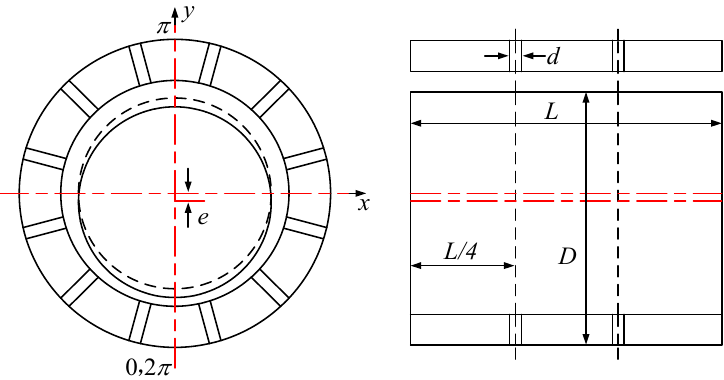
Figure 1. Gas journal bearing structure.